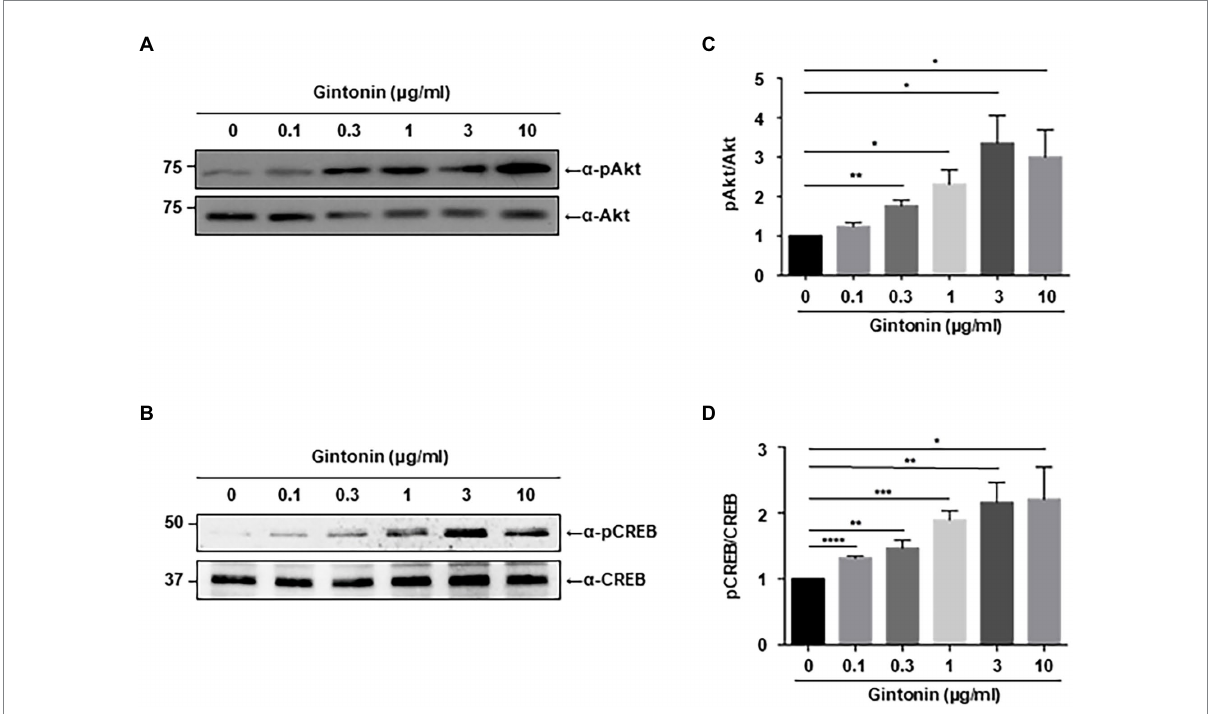
FIGURE 1 Gintonin induces Akt/CREB phosphorylation in the cortical neurons. (A,B) Representative blots showing the effect of gintonin on Akt and CREB phosphorylation. Primary cortical neurons (DIV7) were treated with the indicated concentration of gintonin for 2 h, and the lysates were then used for immunoblot analysis of phospho-Akt, Akt, phospho-CREB, and CREB. Scale bar, 2 μ m. (C,D) Densitometric quantification of the results shown on the right. Results are means ± standard error of mean (SEM) from three independent experiments (* p < 0.05, ** p < 0.01, *** p < 0.0005, **** p < 0.0001, Student’s t